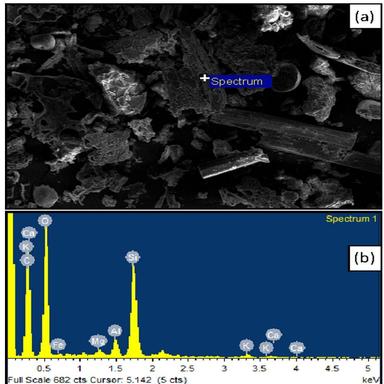
EDAX analysis of fibrous particle (a) SEM image for EDAX analysis (b) Spectrum 1 – Fibrous particle.